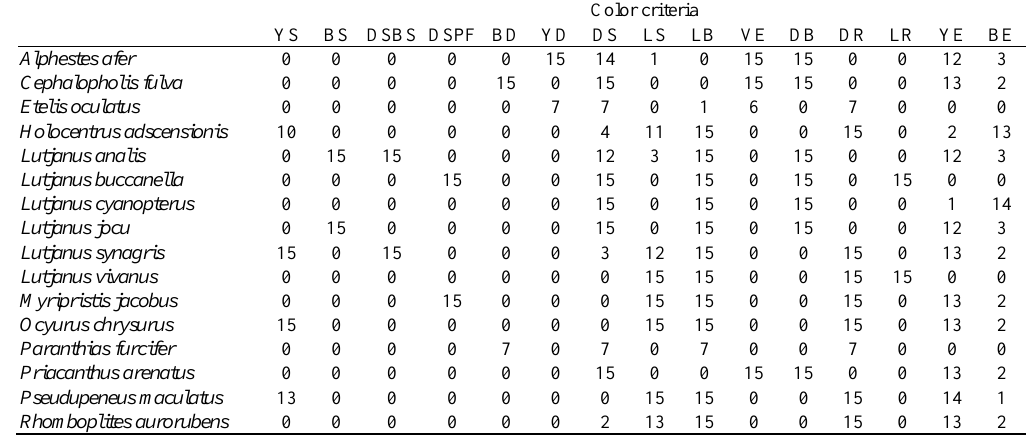
Table 3. Main criteria related to the color used by fishermen to classify integrants of the snapper group with the respective number of obtained answers (number of interviews = 15; for the E . oculatus and P . furcifer n = 7). YS = yellow strip, BS = blue strip, DSBS = dark spot on body side, DSPF = dark spot on pectoral fin, BD = black dots, YD = yellow dots, DS = dark scales, LS = light scales, LB = light belly, DB = dark belly, DR = dark red, LR = light red, YE = yellow eye, DE = dark eye, BE = black eye.